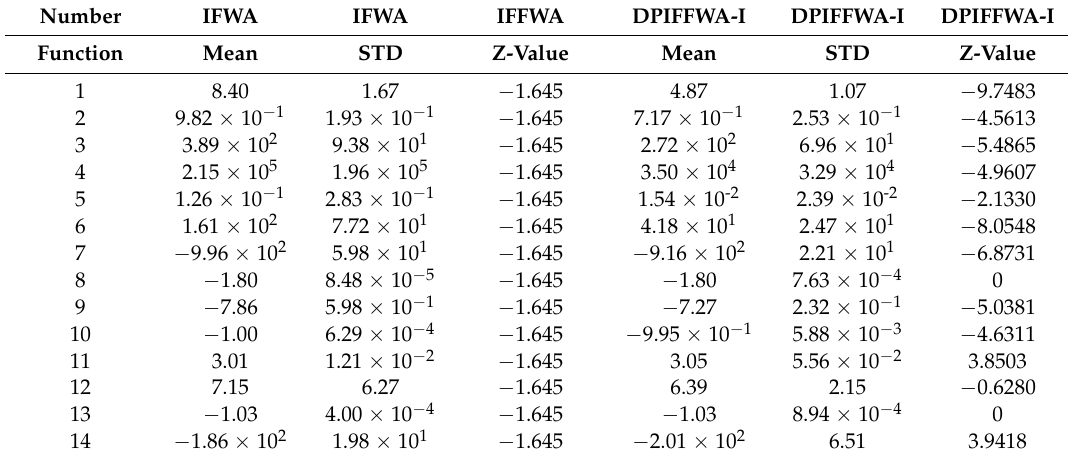
Table 13. Hypothesis test between IFWA and DPIFFWA-I with SI = 2.